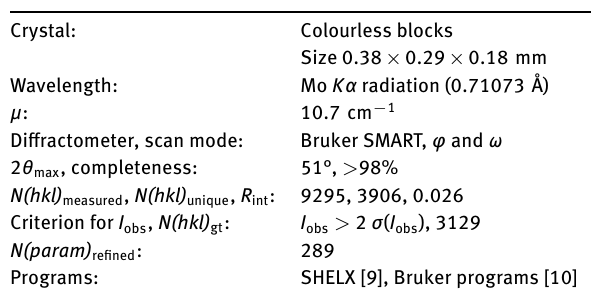
Table 1: Data collection and handling.